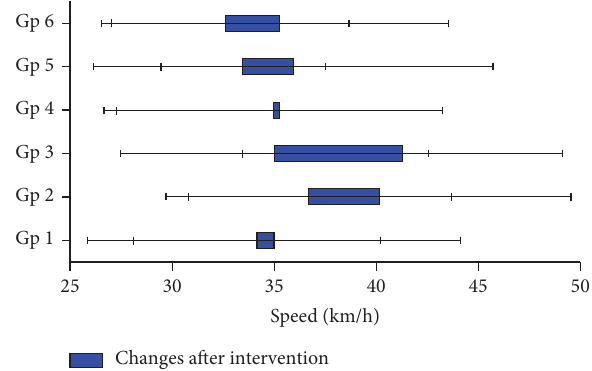
Figure 7: Changes in the mean speed when passing pedestrians after the intervention (the error bars represent the standard variance).